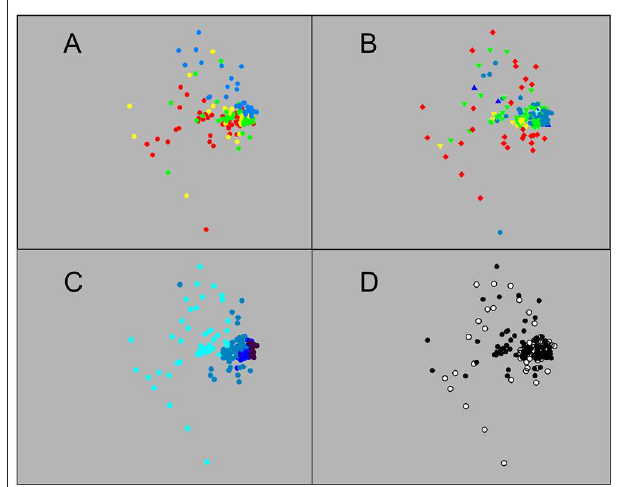
FIGURE 4 | Ordination of the 148 sets based on catch weight: Sets identified by (A) survey, (B) station, (C) maximum depth reached, and (D) diel phase, using same colour coding as in Figure 3 (MDS 2D stress